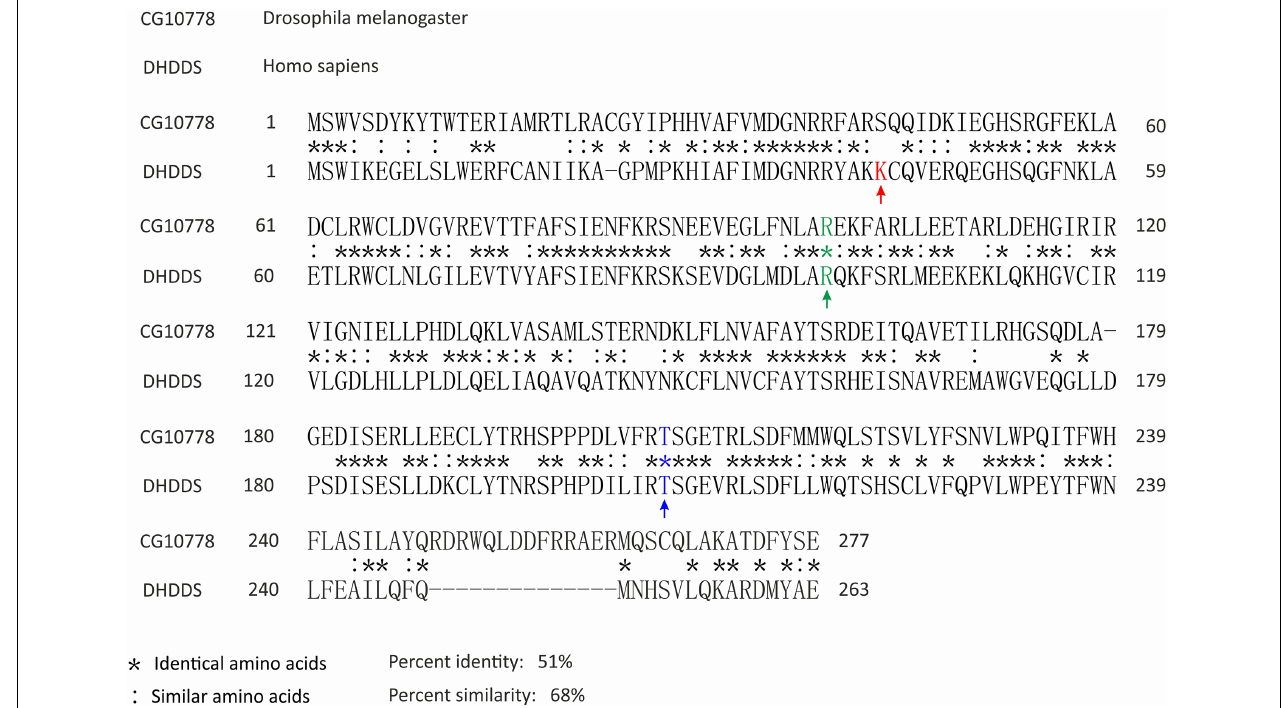
FIGURE 1 | Amino acid sequence alignment of the human DHDDS and its Drosophila ortholog proteins. The amino acid sequences of the human DHDDS and the Drosophila CG10778 proteins were aligned by BLASTp. Positions with identical amino acids were labeled with (*), while positions that preserved the physico-chemical properties of the original residue were marked with (:). Marked with arrows and in color are the DHDDS sites known to be involved in non-syndromic Retinitis Pigmentosa: K42 (red), R98 (green), T206 (blue). Only R98 and T206 are identical in the Drosophila orthologue CG10778. NCBI accession numbers are as follows: NP_572425.1 (CG10778) and NP_995583.1